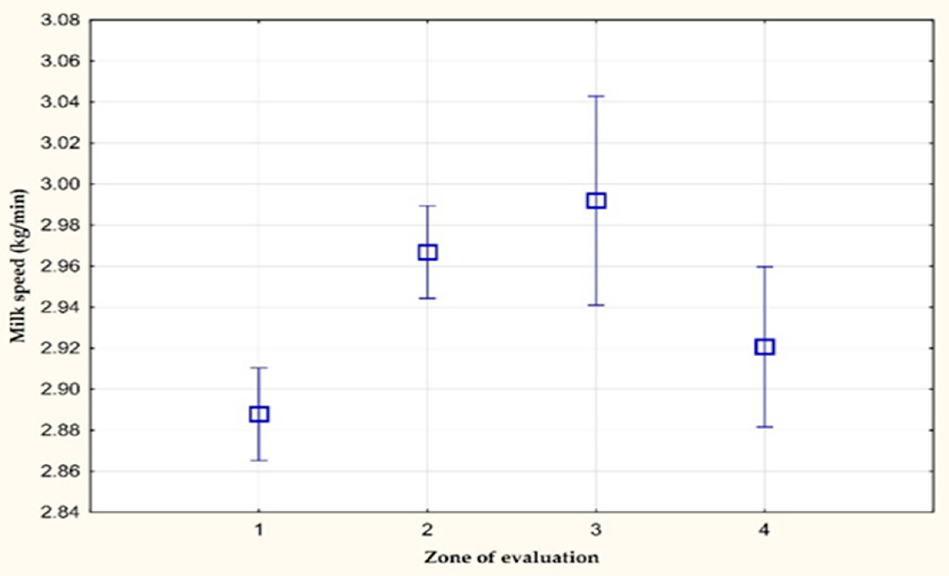
Figure 5. The average milk speed (kg/min) on farm D.